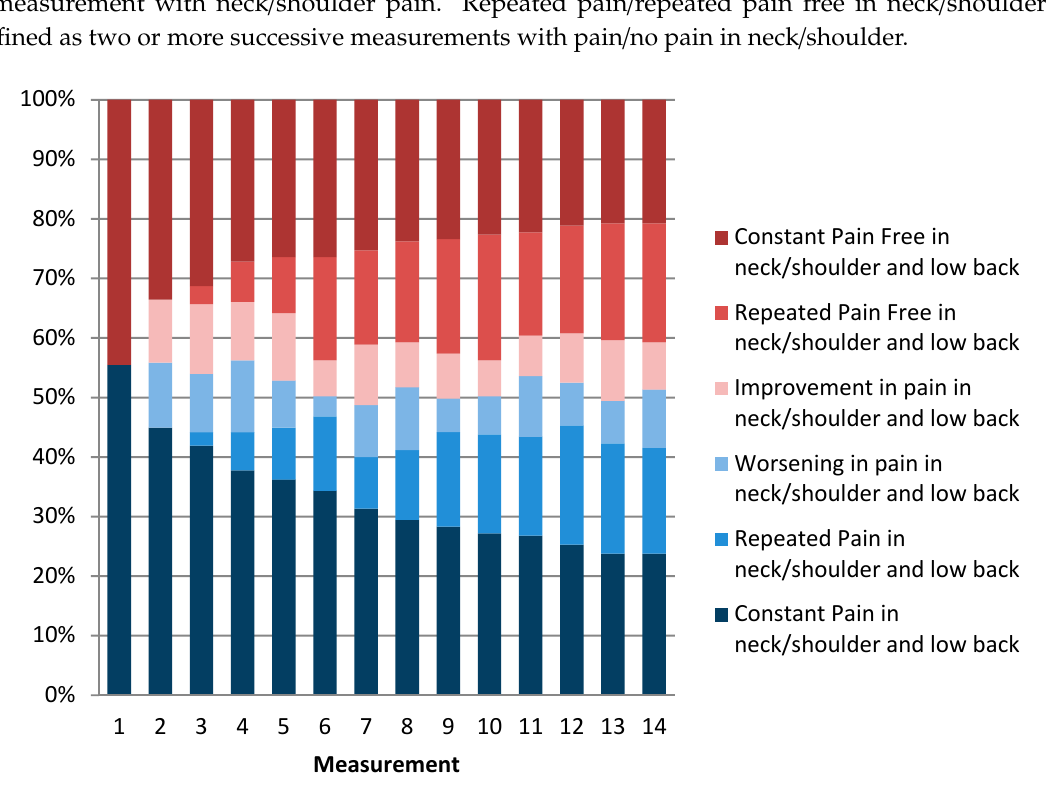
Table 2. Average duration of low back pain and neck/shoulder pain and pain-related interference with work (total days per four weeks and total days per year).